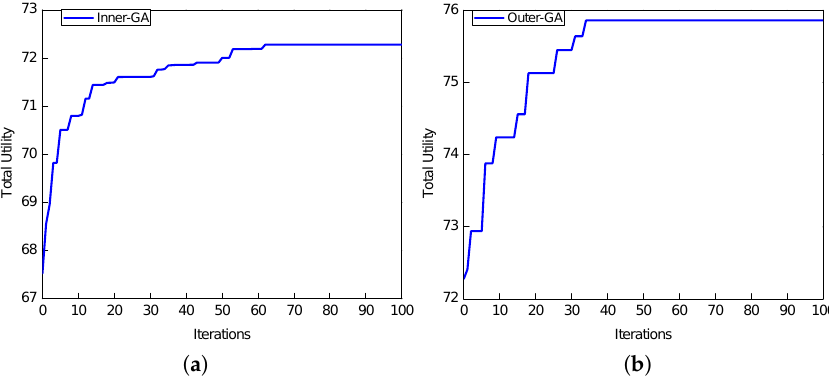
Figure 6. Convergence of the proposed algorithm. ( a ) Inner-GA; ( b ) Outer-GA.